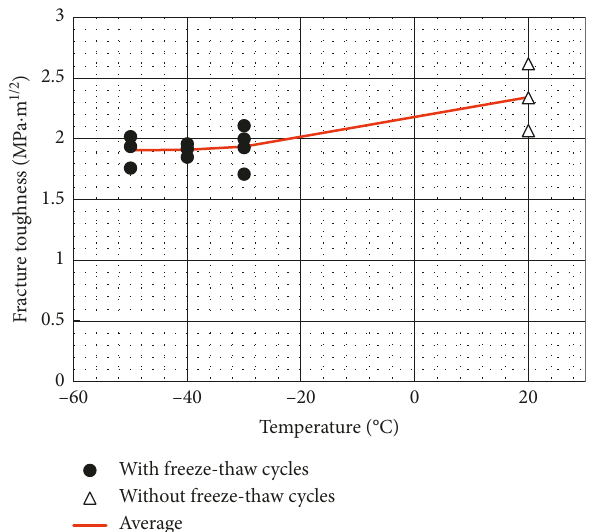
Figure 13: Fracture toughness of tonalite with and without exposure to freeze-thaw